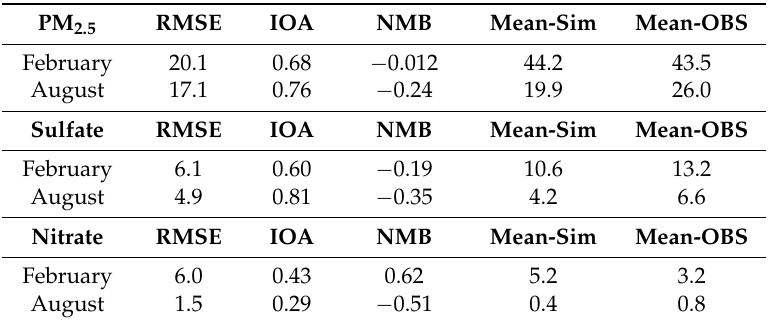
Table 2. Evaluation of hourly particulate matter (PM 2.5 ), sulfate and nitrate simulated by Comprehensive Air Quality Model with Extensions (CAMx).